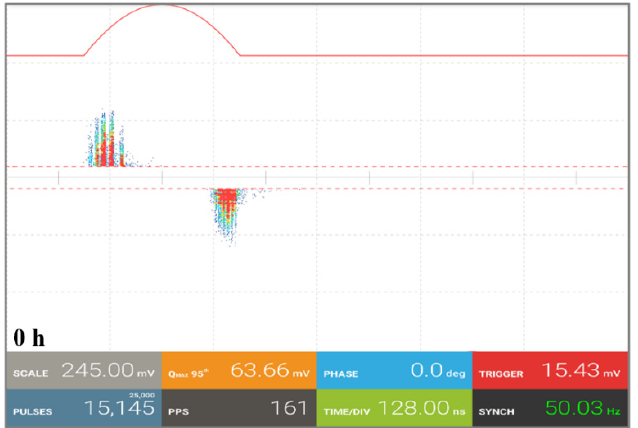
Figure 8. DCP voltage PRPD patterns with δ = 0.6, acquired after a few minutes of voltage application.